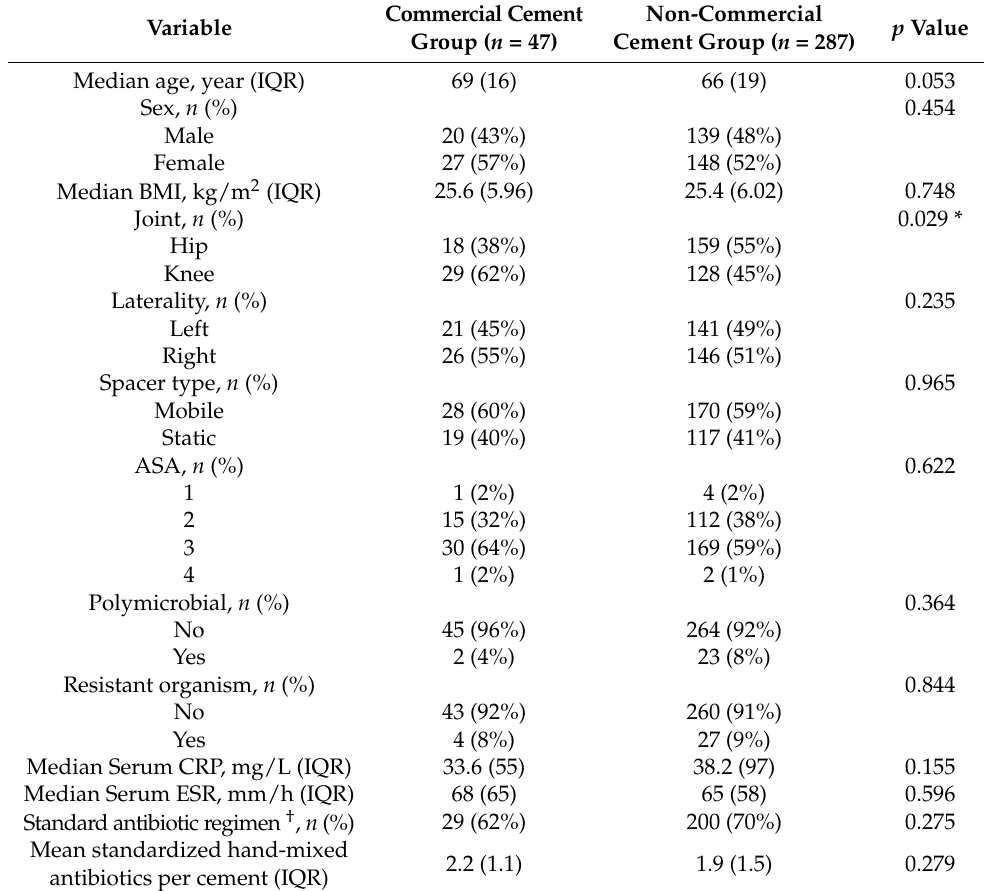
Table 1. Patients’ demographics between the two